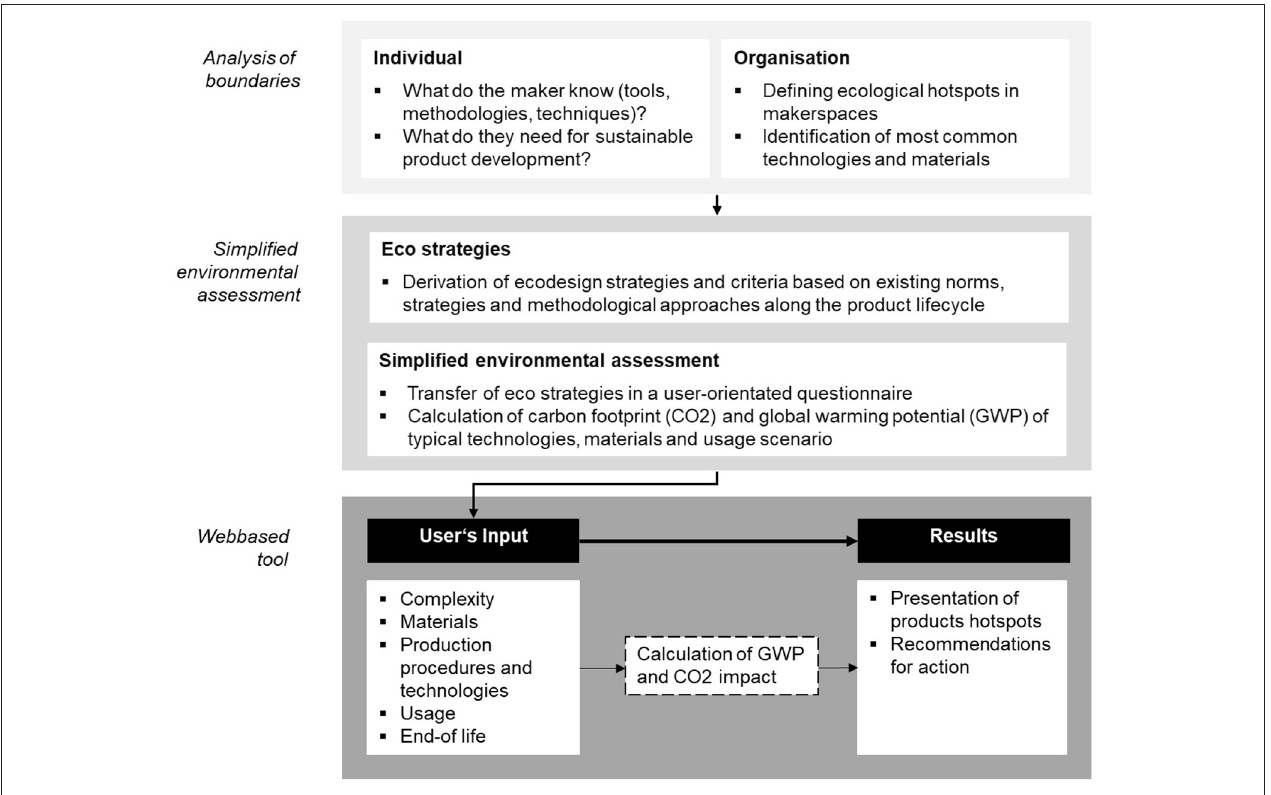
FIGURE 8 | Principles behind the ecoMaker